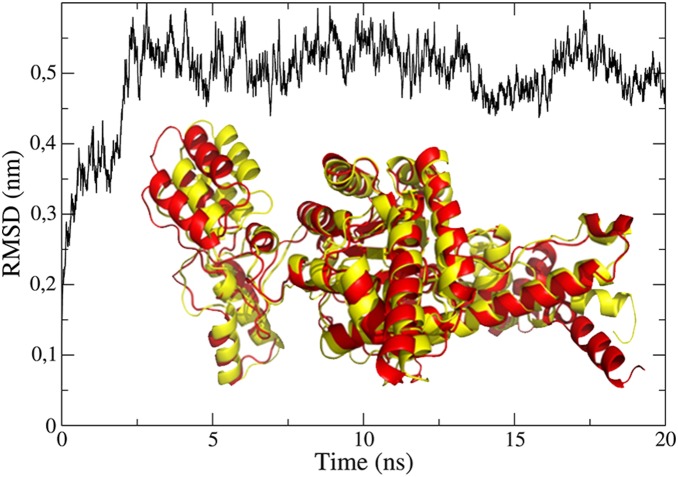
Dynamic profile for RMSD obtained in molecular dynamic simulations of PbICL after 20 ns.Superimposition of the homology model (red) and molecular dynamic structure (yellow) of PbICL is shown. The molecular dynamic-model structure was obtained using the program g_cluster, which determined the conformation that best represents the last 10 ns of the trajectory.